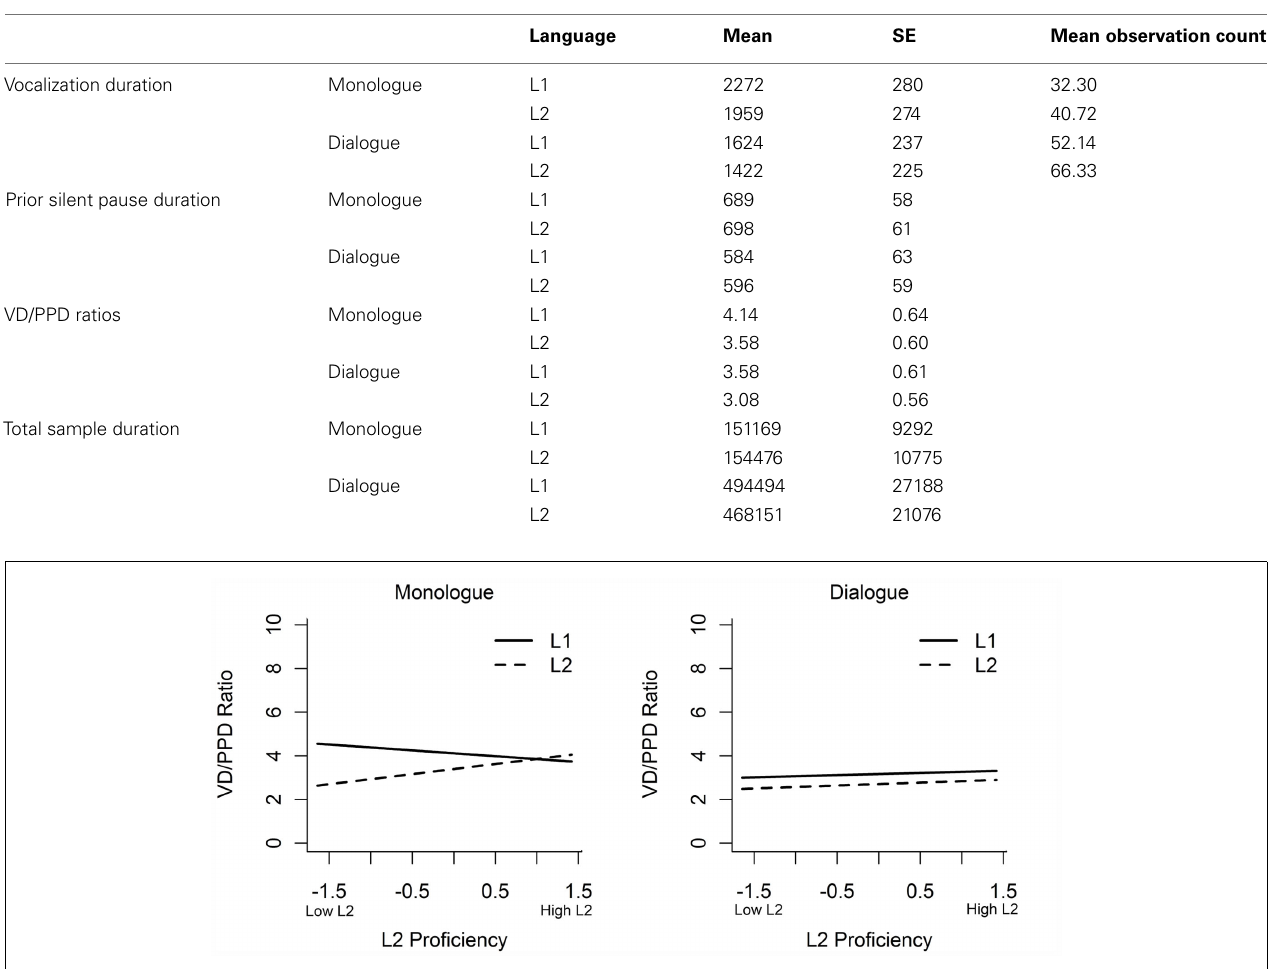
Table 5 | Mean values (ms), SEs of the mean, and mean observation count for vocalization durations, prior silent pause durations, computed VD/PPD ratios, and total speech sample duration for monologues and dialogues in L1 and in L2.